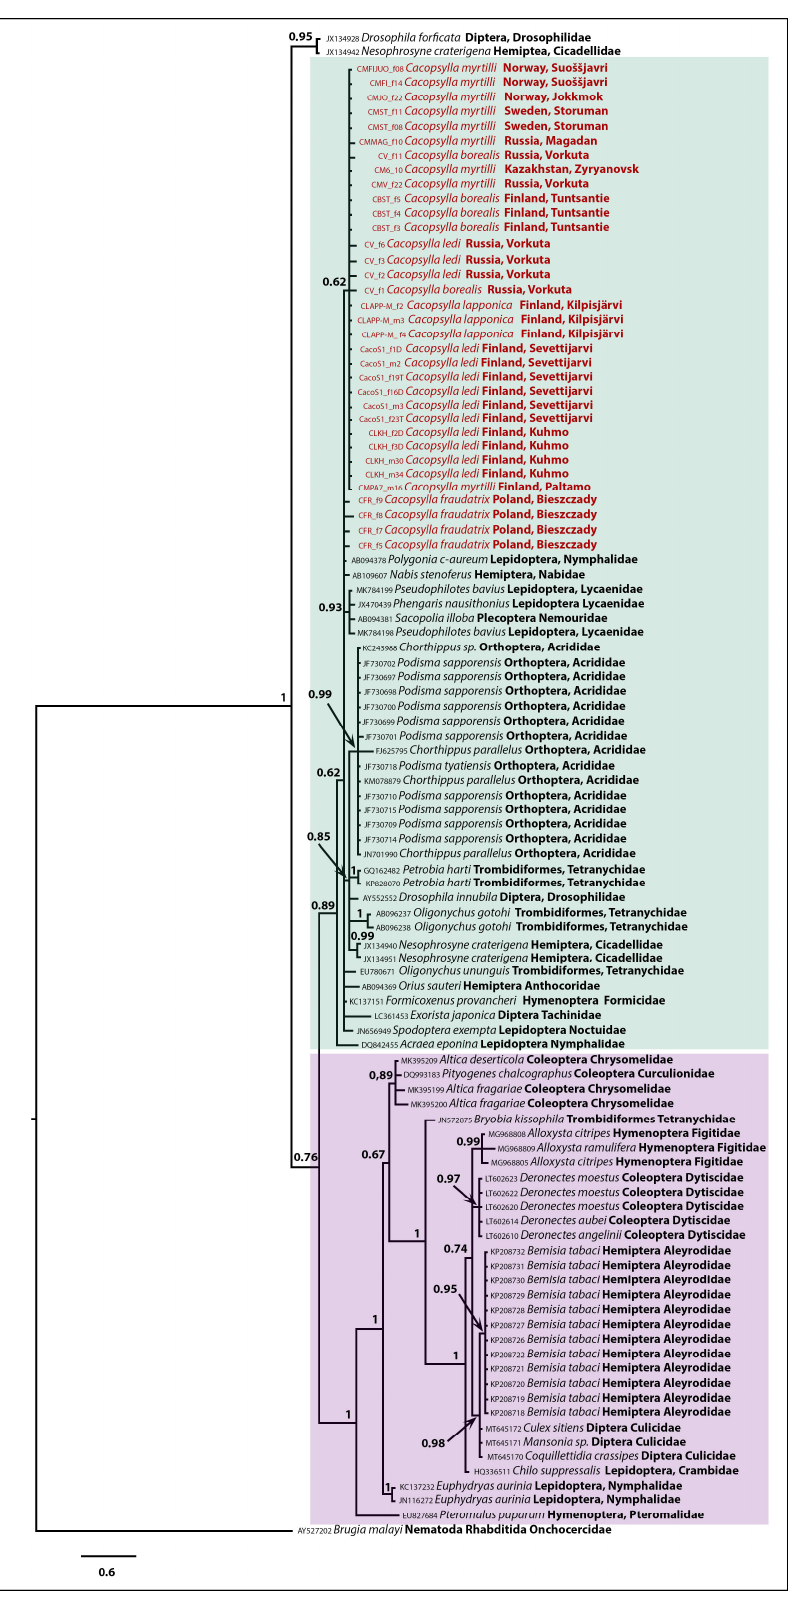
Figure 4. The Bayesian tree of analyzed Wolbachia samples. Numbers at nodes indicate Bayesian posterior probability. Scale bar = 0.6 substitutions. Revealed Wolbachia clusters are highlighted in violet and green.